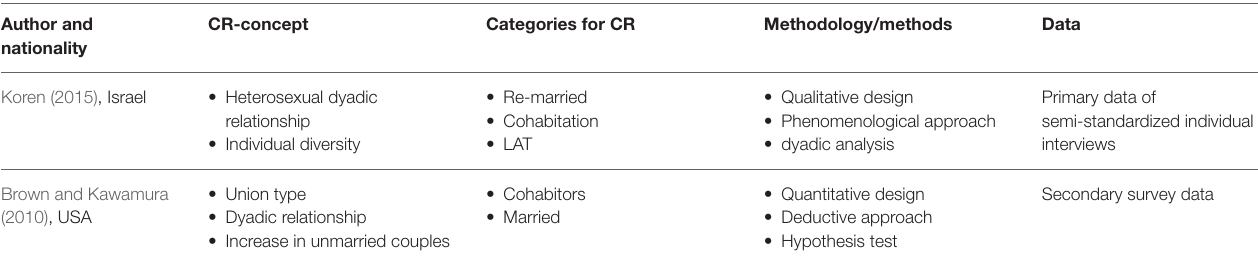
TABLE 1 | Comparison of selective effects in two studies on CR in old